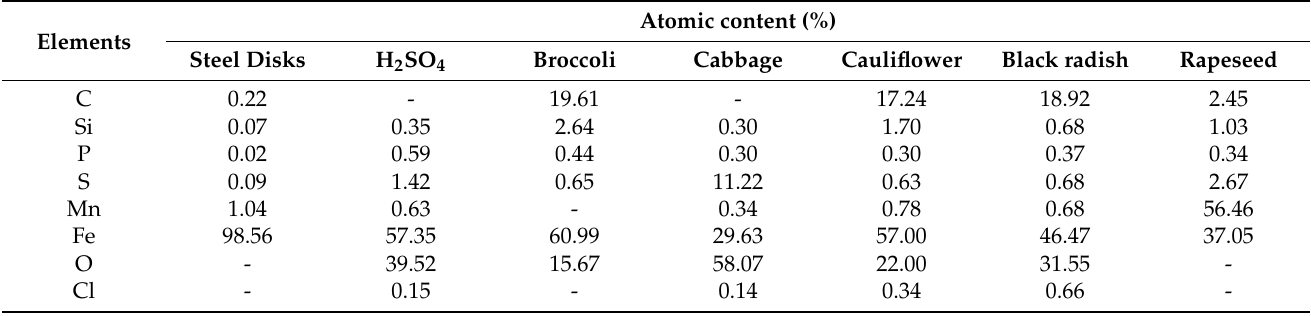
Table 6. Percentage of atomic contents of elements obtained from EDX